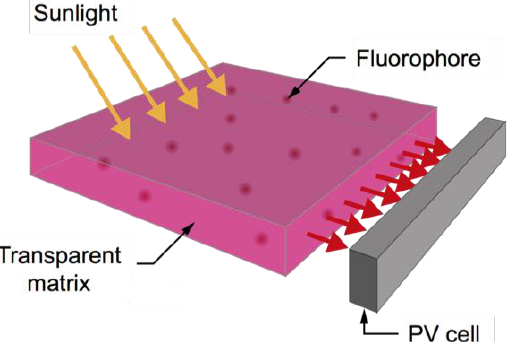
Figure 1. Working principle of the luminescent solar concentrators (LSC) / photovoltaic systems (PV)